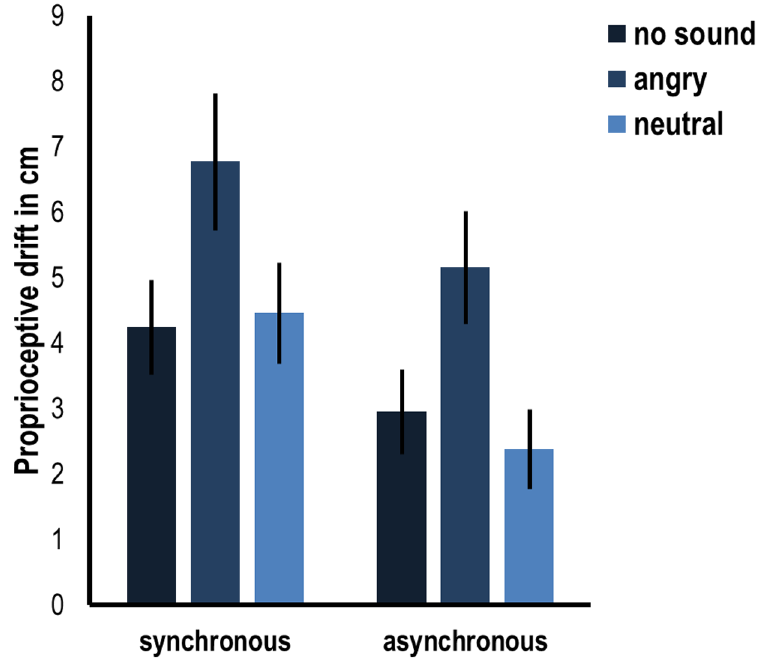
Fig 4. Average proprioceptive drift in cm in the different conditions of experiment 2 (no sound, angry vocal and neutral vocal) in synchronous and asynchronous stroking. Error bars indicate standarderror.